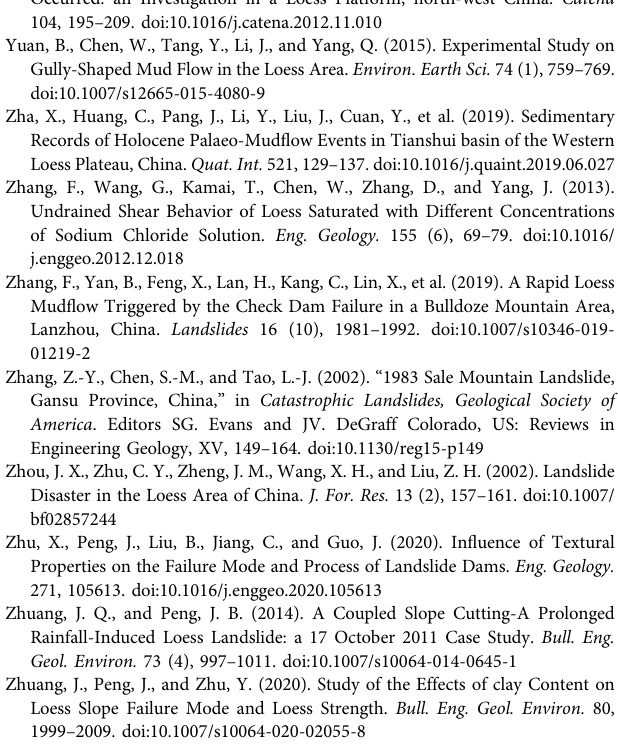
Tableland. Eng. Geology. 236, 129 – 136. doi:10.1016/j.enggeo.2017.05.006 Liu, T. S. (1985). Loess and the Environment . Beijing, China: Science Press.